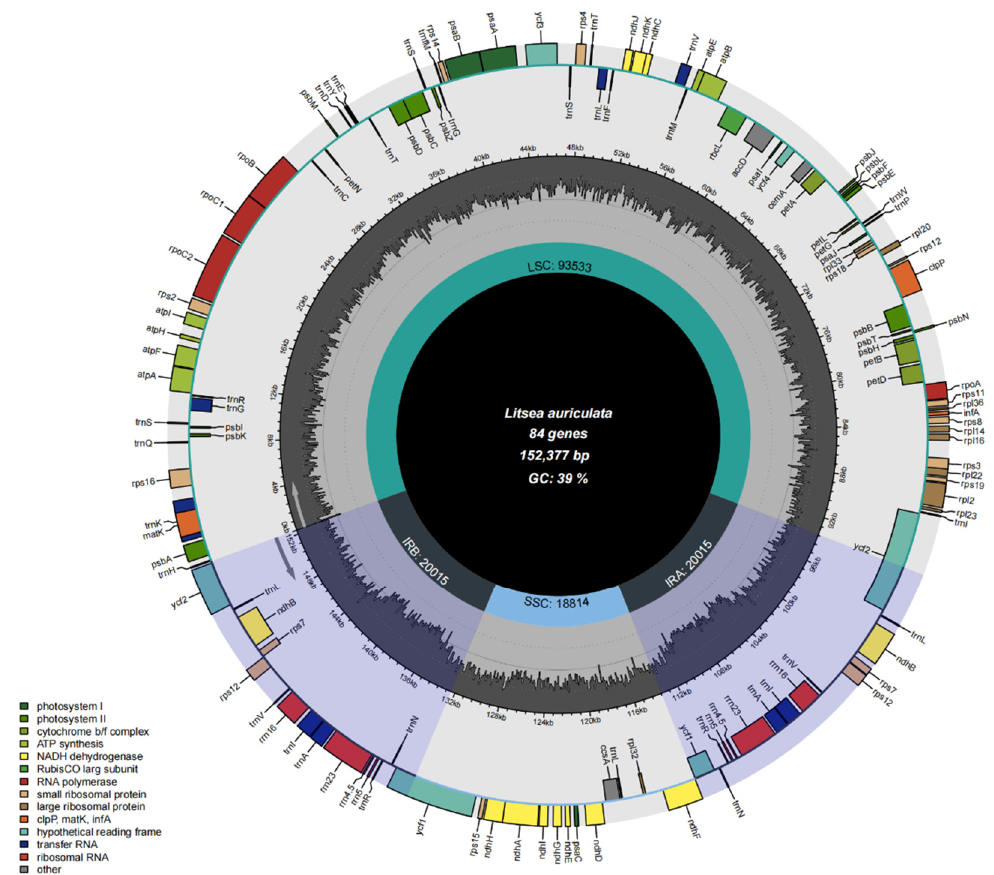
Figure 1. Complete genome map of the chloroplast genome for representative species L. auriculata . The inner gray ring is divided into four areas, clockwise, and they are SSC, IRb, LSC, and IRa. The genes in the outer ring region are transcribed clockwise, while those in the inner ring are transcribed counterclockwise. In addition, this figure also reflects the GC content; the inner ring dark gray indicates the GC content, the light gray reaction AT content. In the lower left is a legend that classifies cp genes according to their functions. Table 1. Gene content of the L. moupinensis chloroplast genome.